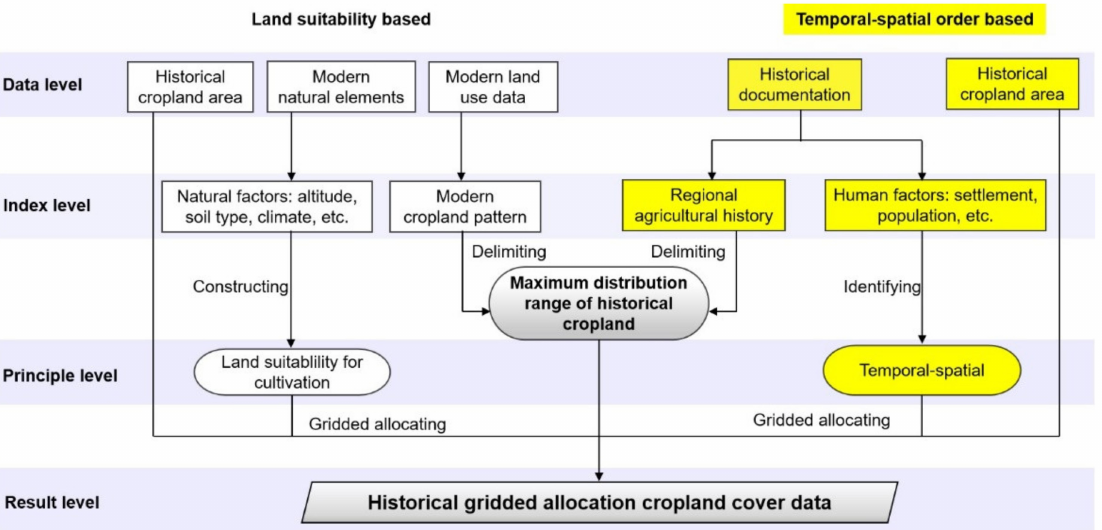
Figure 1. A comparison of two methodological frameworks for gridded allocation of historical cropland cover. The one to the left is widely used, and the one to the right, highlighted in yellow, was introduced in this